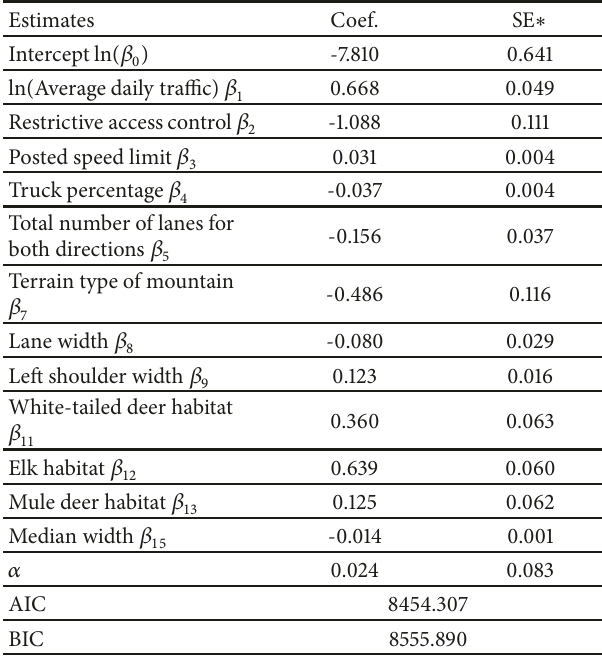
Table 6: Modelling results of reported AVCs for NB models with the Washington data.